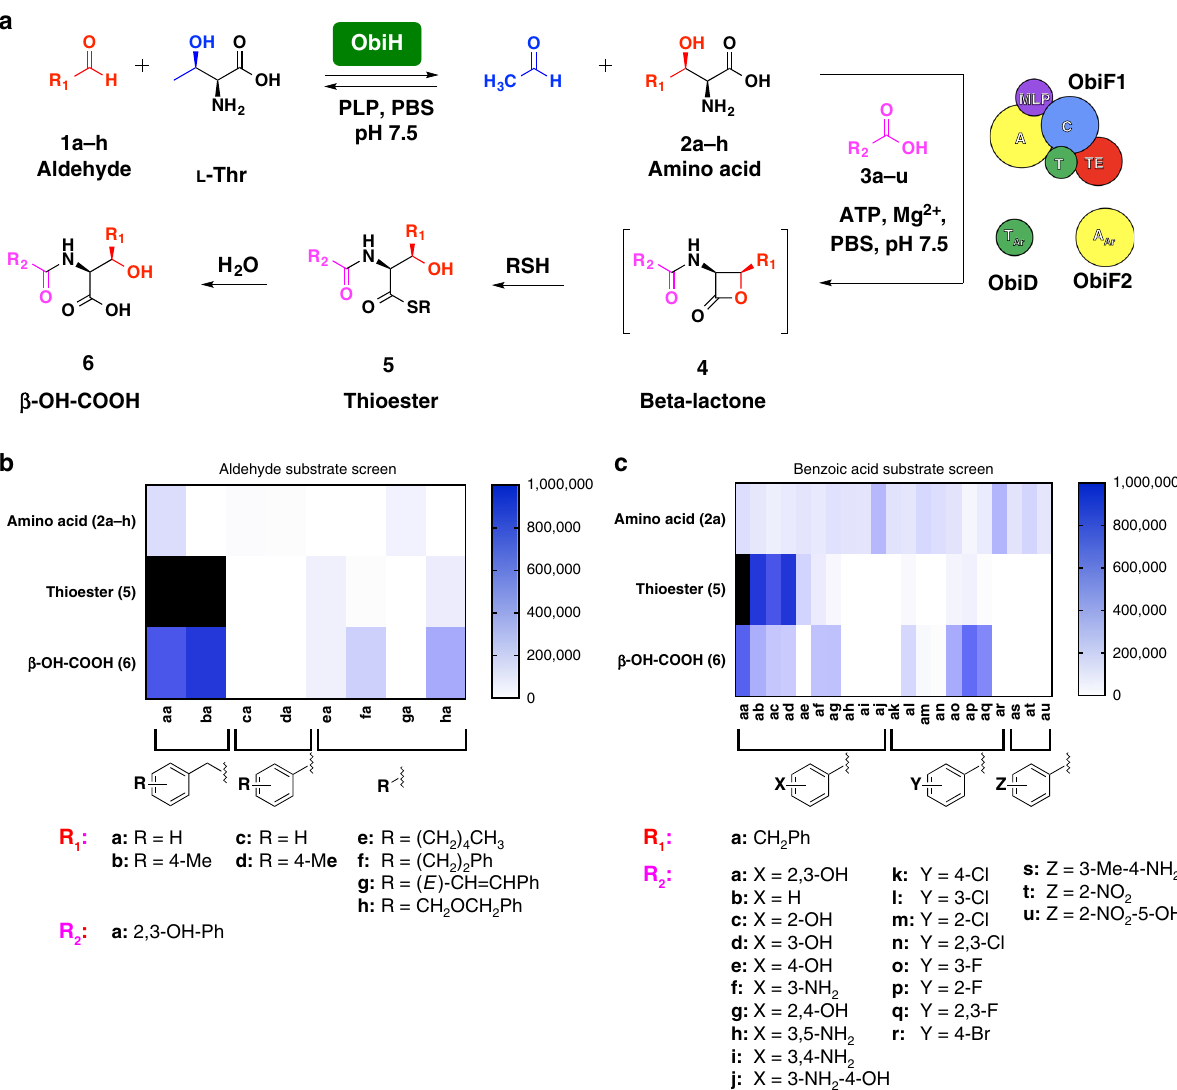
Fig. 6 Probing NRPS substrate scope. a Scheme depicting the reaction conditions for the coupled ObiF1/F2/D/H in vitro enzyme assay using a thiol kinetic capture strategy for the β -lactone product. DTT was employed as the reactive thiol. Thioester and β -hydroxy acid product ion counts were quanti fi ed via LCMS (see Supplementary Data 1 for [M + H] + m / z values and EIC traces). Heat maps represent the extracted ion counts for the amino acid (2 a – h ), thioester ( 5 ), and β -hydroxy acid ( 6 ) resulting from the use of variable b aldehyde (1 a – h ) or c benzoic acid (3 a – u ) substrates normalized to a phenylalanine internal standard for one trial at the 24 h reaction time point. For compounds ( 4 – 6 ), the fi rst letter in the two-letter nomenclature, ( a – h ), represents the structure of R 1 while the second letter in the two-letter nomenclature, ( a – u ), represents the structure of R 2 . Heat maps for additional time points (0.5 and 3 h) are provided in the Supplementary Information. The color scale to the right of each fi gure re fl ects peak counts; peaks above 1,000,000 counts are colored